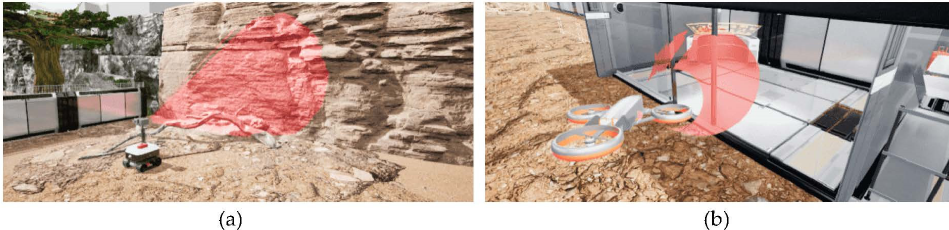
Figure 9. Future data collection techniques ( a ) Laser scanner rovers, ( b ) survey UAV (source: Au- thor).